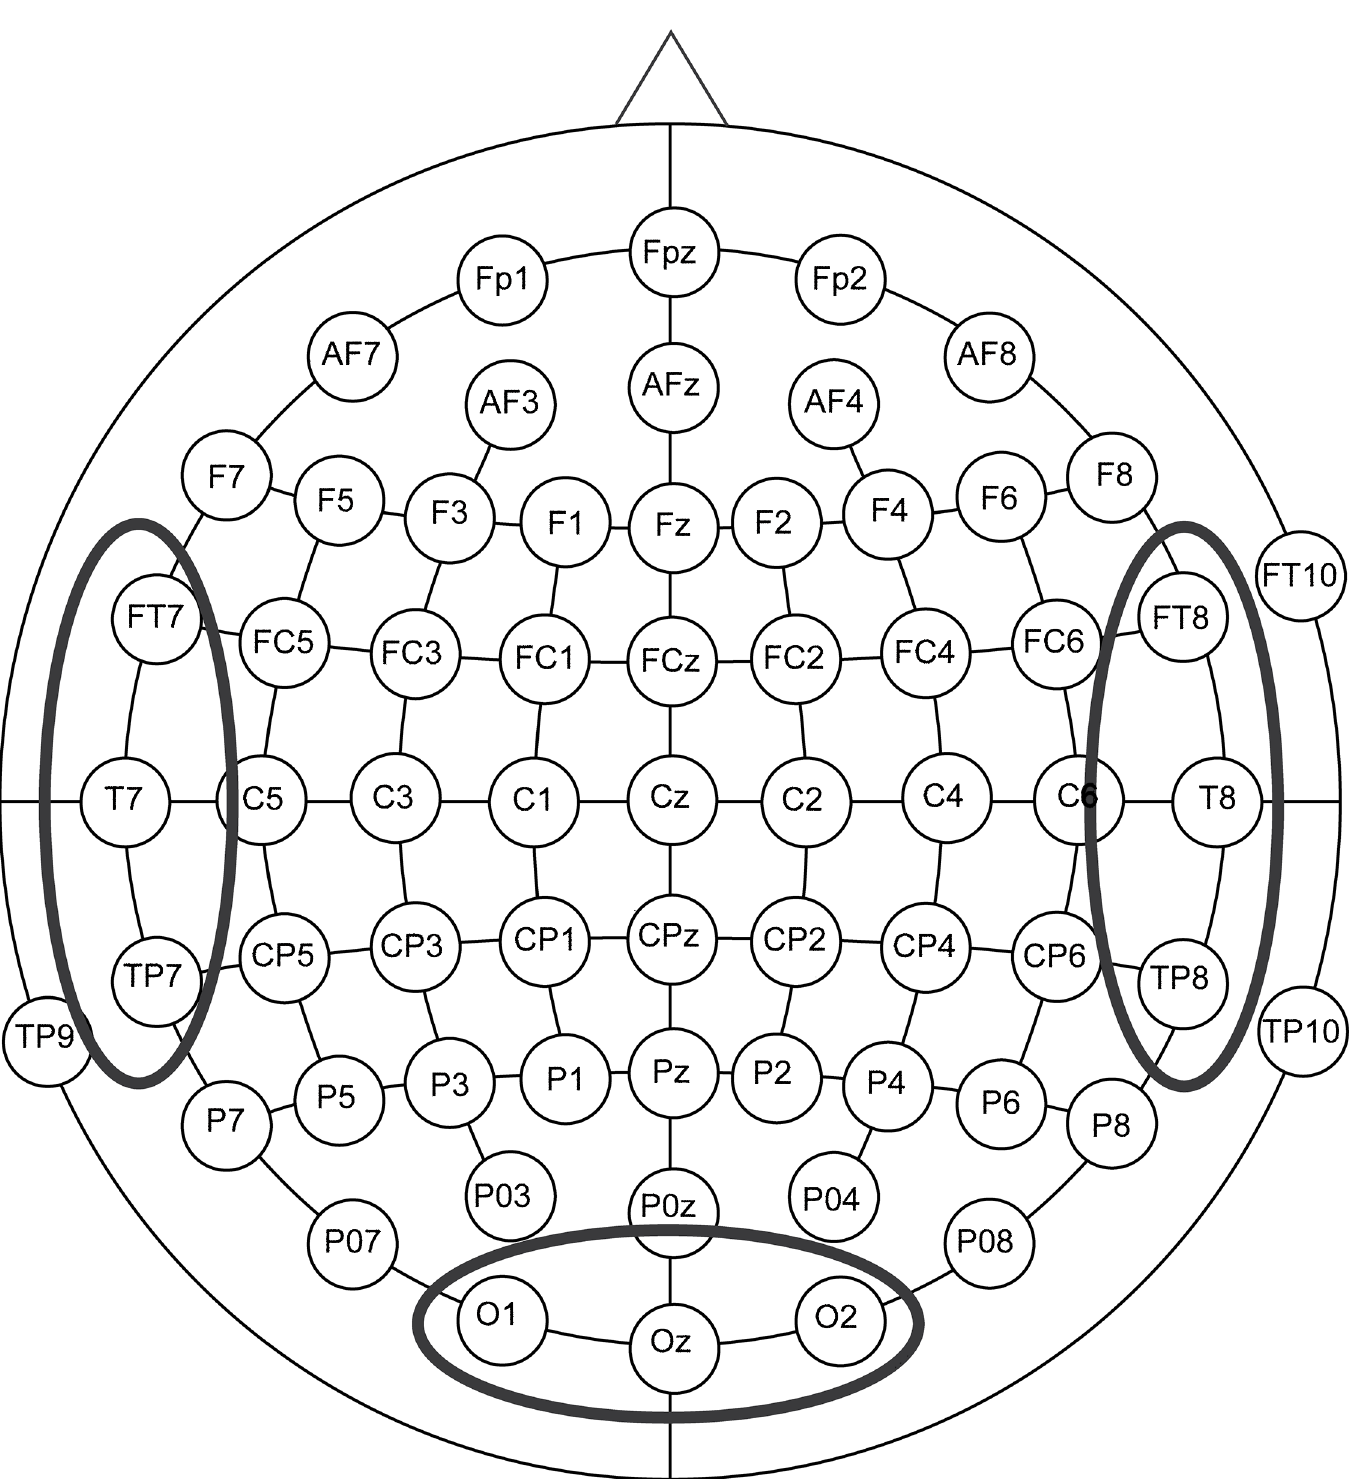
Fig 1. Location of the electrodes for VEP analysis. For evaluating different cortical activity to visual stimuli, we determined the region of interest reflecting each cortex for VEP analysis. We averaged amplitudes and latencies of the VEP response from three electrodes over located each cortex for each participant. The response from left temporal cortex was averaged with FT7, T7 and TP7. Similarly, right temporal cortex was from FT8, T8 and TP8. Occipital cortex was from O1, Oz and O2. Elliptical circles indicated each electrodes group for analysis.